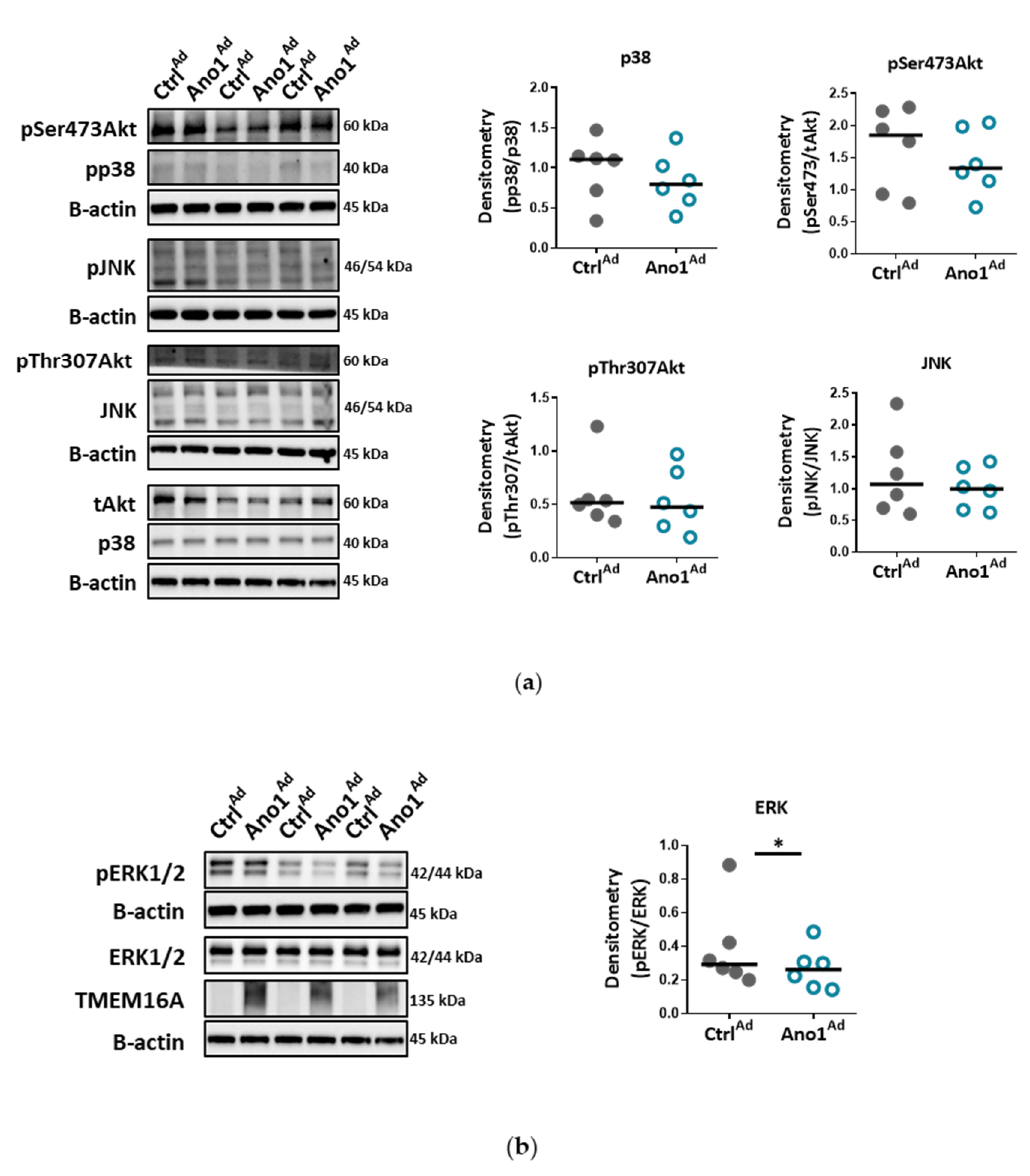
Figure 7. Elevated TMEM16A activity alters ERK1/2 signaling. ( a ) Western blots showing protein levels of p38, Akt and SAPK/JNK obtained from of PAECs infected with either Ano1 Ad or control Ctrl Ad . Figures were generated with 6 samples. ( b ) Western blots showing ERK1/2 pathway activation in PAECs infected with either Ano1 Ad or Ctrl Ad with quantification. Figures were generated with 6 samples. * p < 0.05, ratio-paired t-test.